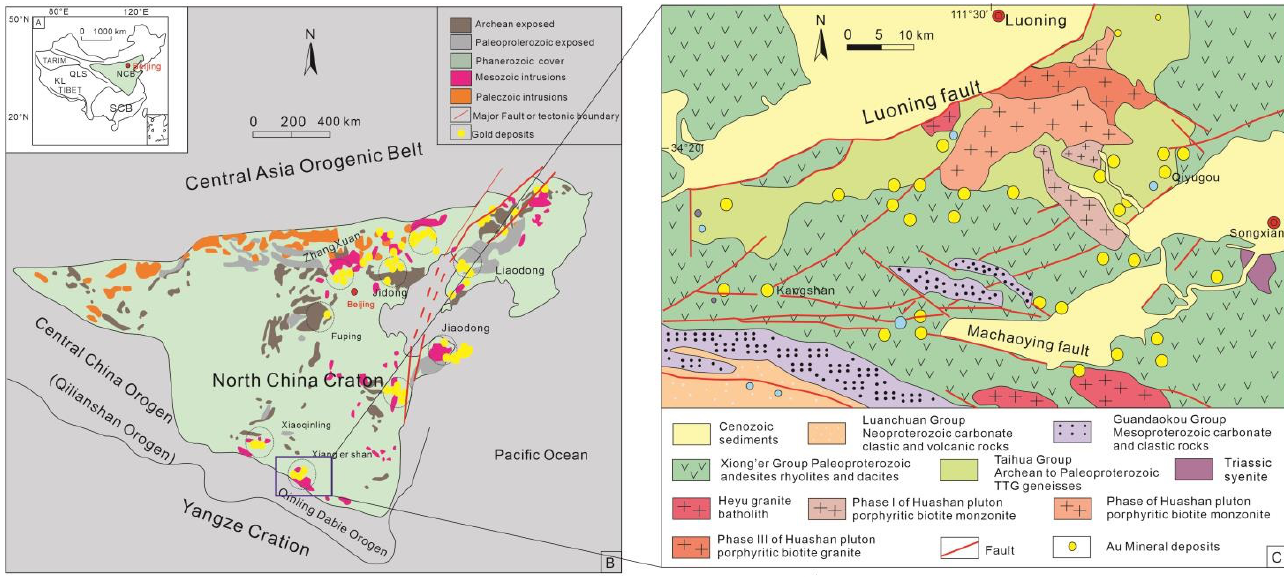
Figure 1. Simplified geological maps of the Xiong’ershan, Henan province in China: ( A ) map showing the location of the NCC; ( B ) the location of the Xiong’ershan ore clusters within the CNN (modified after [123–125]); and ( C ) regional geologic map of Xiong’erhsan district and distribution of gold deposits in the region (modified after [126 – 128]).